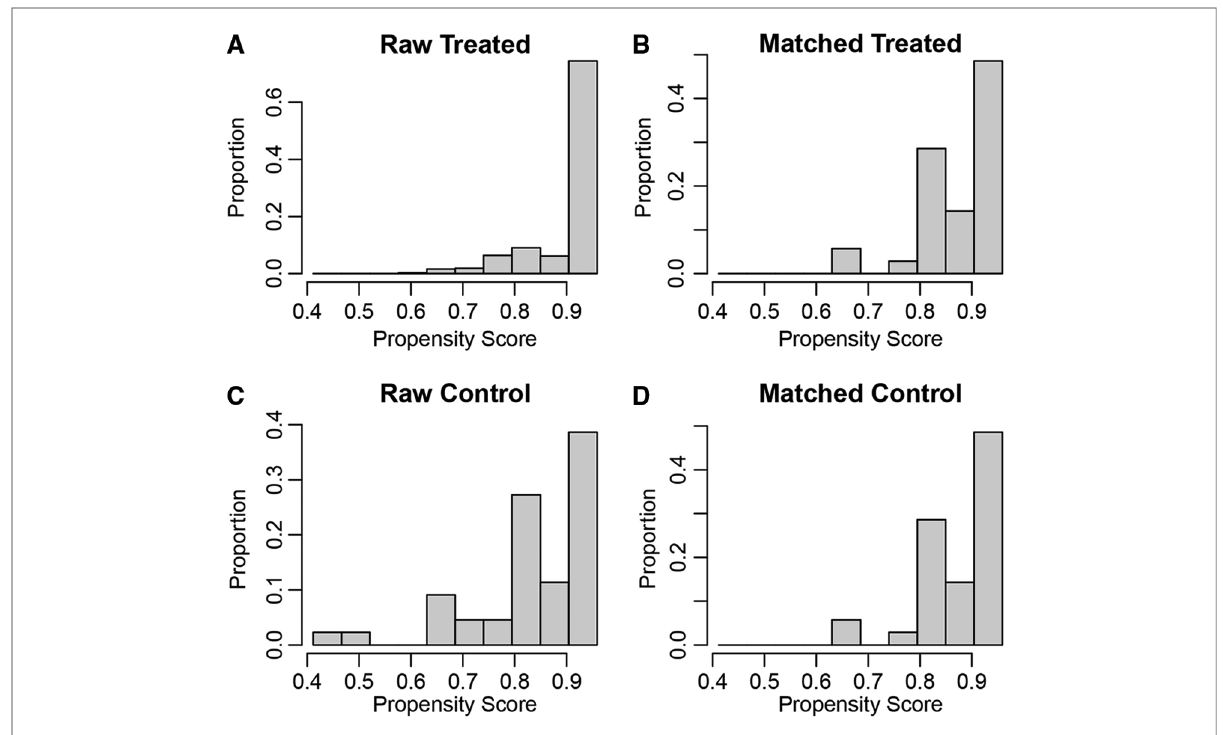
FIGURE 2 The propensity score results for overall survival ( A,B ) and cancer-speci fi c survival ( C,D ) after propensity score matching.